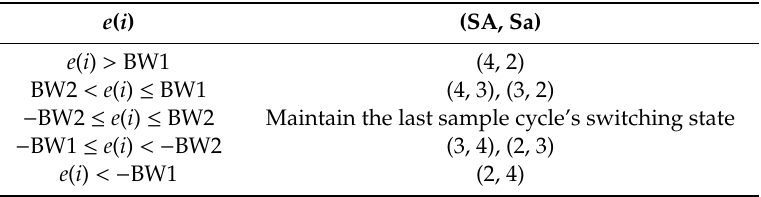
Table 2. Switching Status for Hysteresis Controller (Phase